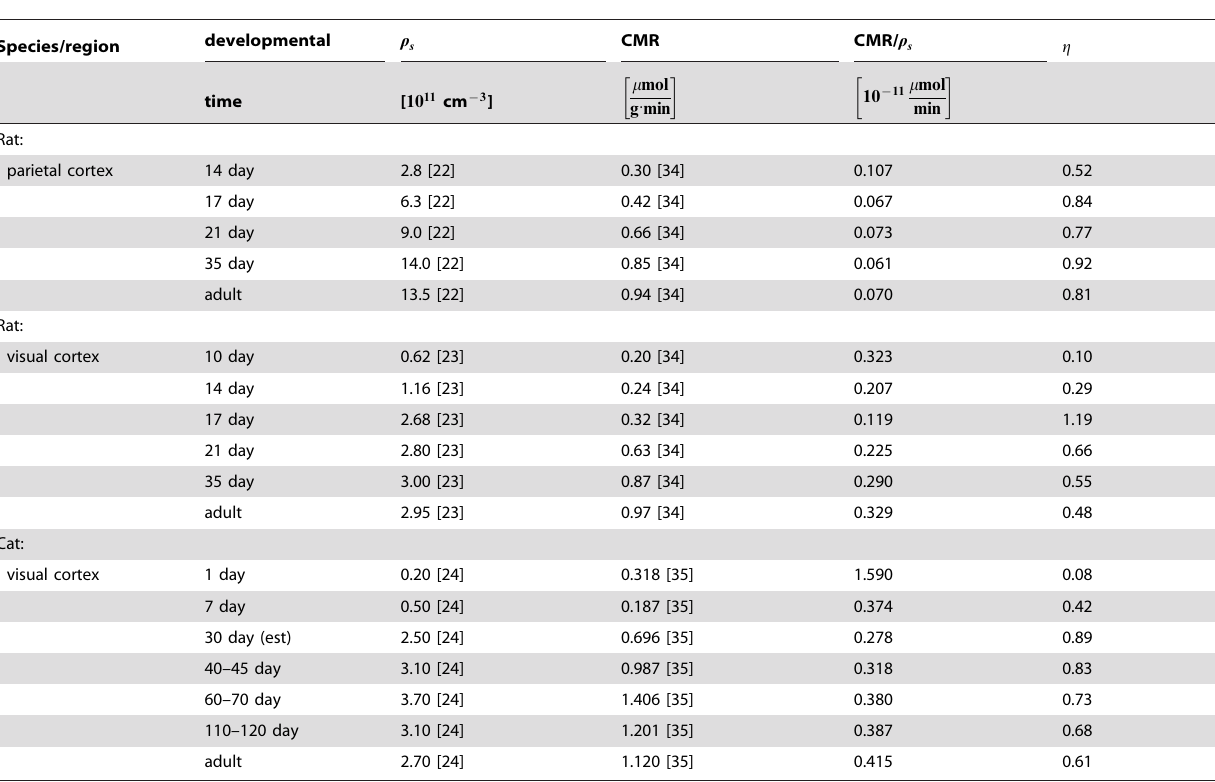
Table 1. Synaptic and metabolic development for rat and cat cerebral cortex.